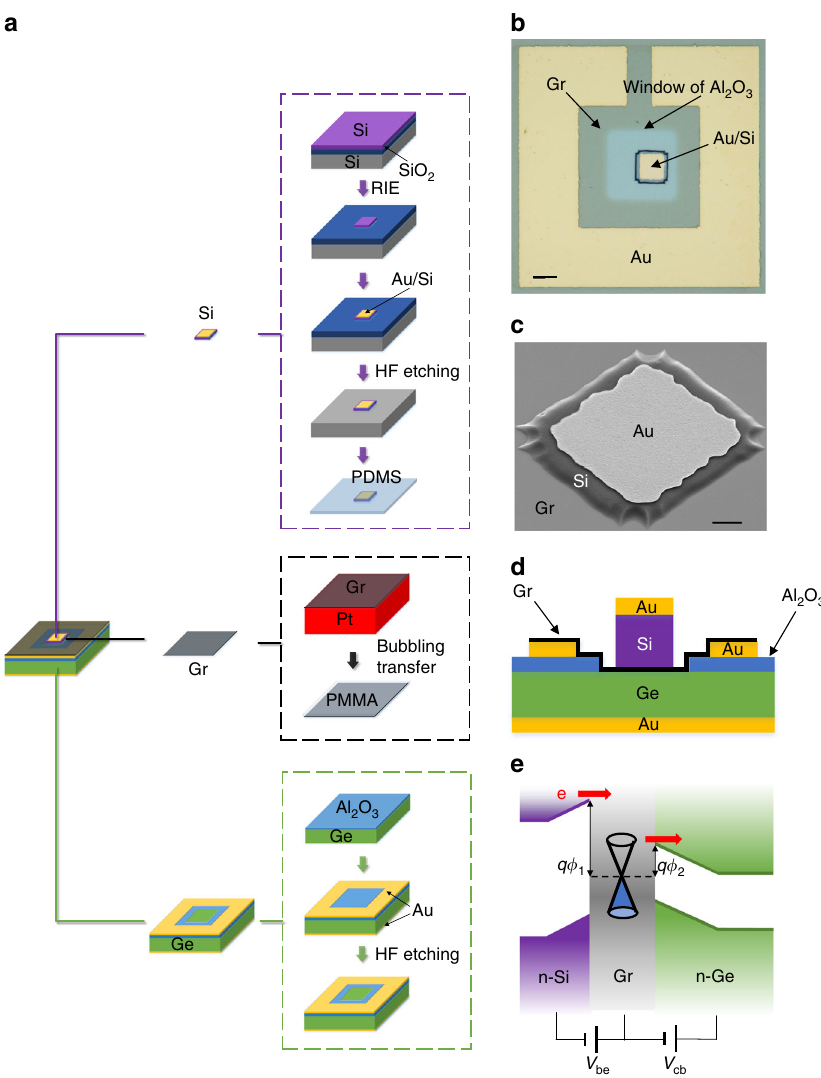
Fig. 1 Device design and fabrication. a A Si – Gr – Ge transistor is built by directly stacking a Si membrane, single-layer graphene and a Ge substrate. b Optical image of a Si – Gr – Ge transistor (scale bar: 20 μ m). c SEM image of a Si membrane on graphene (scale bar: 4 μ m). d Illustration of the cross-section of